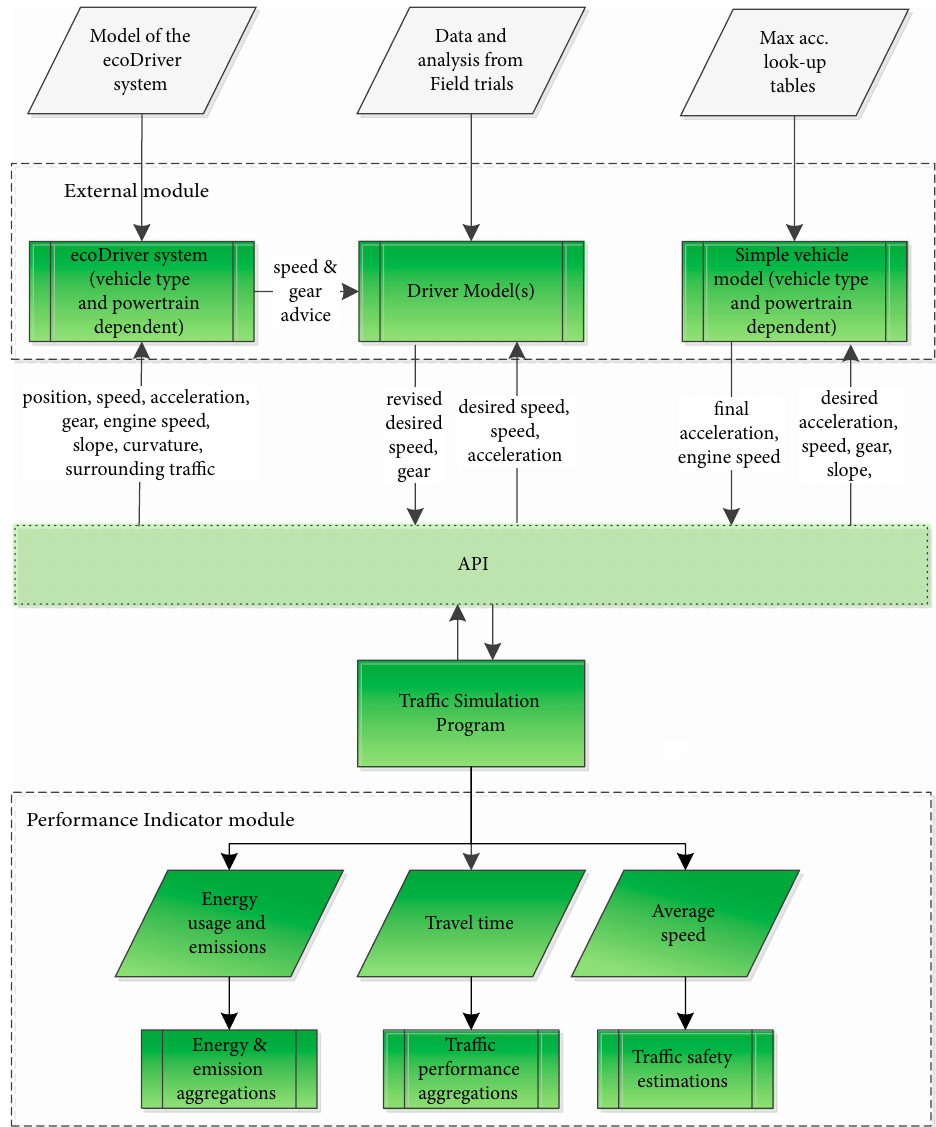
Figure 2: The traffic simulation